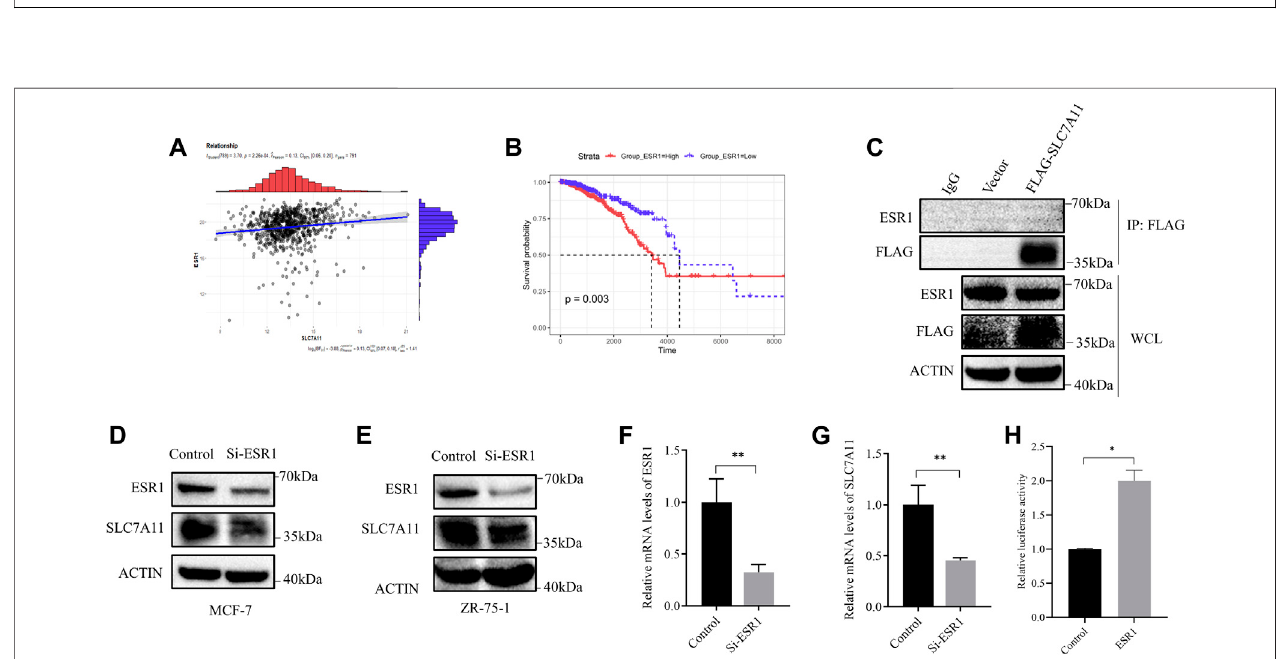
FIGURE 3 | Correlation between ESR1 and SLC7A11 in ER-positive cancers. (A) Scatter plots for correlation analysis of ESR1 and SLC7A11. The dark gray line means alinear regression line and the gray region is95% con fi dence region. (B) Kaplan – Meier curveof OS in ER-positive cancers according toESR1 expression. (C) IP assay of MCF-7 cells transfected with a plasmid expressing FLAG-tagged SLC7A11. (D – G) Western blot and qRT-PCR analysis showed that si-ESR1 reduced SLC7A11 expression in MCF-7 (D,F,G) and ZR-75-1 (E) . (H) Effect of ESR1 on SLC7A11 transcription by double fl uorescein-reporter enzyme activity in MCF-7. Shown is mean ± SD, n ≥ 3, * p < 0.05; ** p < 0.01.